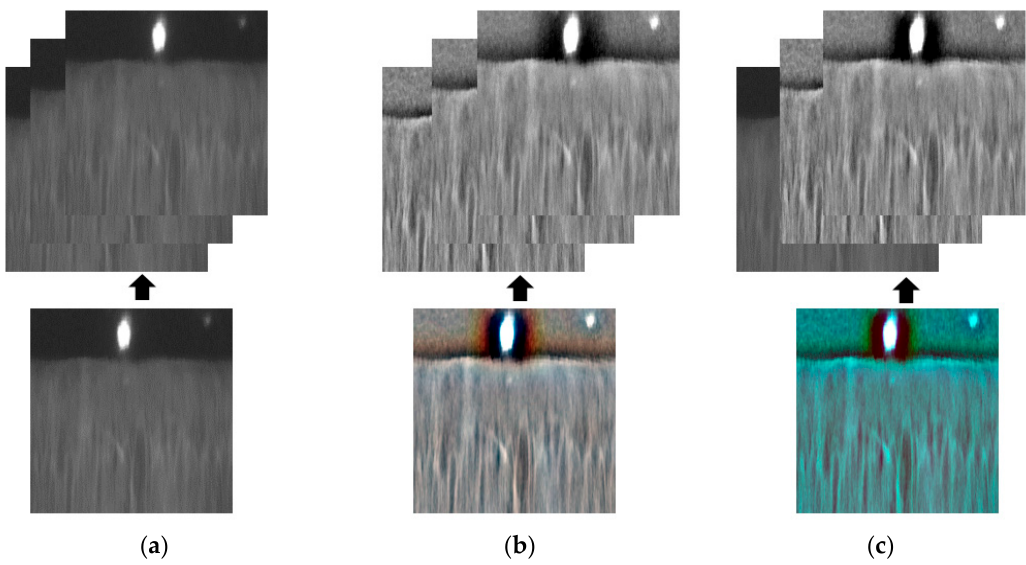
Figure 6. Demonstration of three ‐ channel input image to CNN: ( a ) three ‐ channel gray image, ( b ) three ‐ channel Retinex image with sigma of 10, 15 and 20, and ( c ) three ‐ channel fusion of one gray and two Retinex images with sigma of 10 and 15.